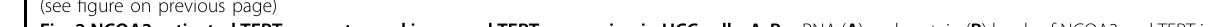
Fig. 2 NCOA3 activated TERT promoter and increased TERT expression in HCC cells. A , B mRNA ( A ) and protein ( B ) levels of NCOA3 and TERT in Hep3B and HepG2 cells with NCOA3 knockdown. C Activity of different fragments of TERT promoter was determined by dual-luciferase reporter assay with transfection of pGL4.10-TERT-truncation/pRL-TK plasmids as the ratio of 50:1 in Hep3B cells without and with NCOA3 knockdown. The fi re fl y luciferase activity was normalized to the renilla luciferase activity. D TERT promoter activity was decreased with NCOA3 knockdown. The TERT promoter activity was detected using the − 234 ~ + 40 fragment of TERT promoter according to ( C ) by transfection of pGL4.10-TERT-truncation/pRL- TK plasmids as the ratio of 30:1 in NCOA3 knockdown Hep3B and HepG2 cells. E TERT promoter ( − 234 to + 40) activity was increased in SNU-449 and Hep3B cells with NCOA3 overexpression. F Protein level of NCOA3 and TERT in SNU-449 and Hep3B cells with NCOA3 overexpression. All of the data in the fi gure were from at least three independent experiments and shown as means ± SD. ** P < 0.01. *** P < 0.001, Student ’ s t